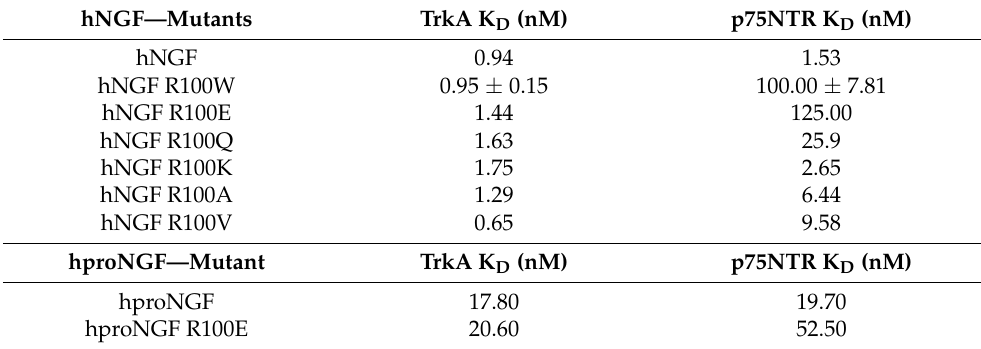
Table 3. Summary of the SPR derived equilibrium-binding constants K D (nM) of hNGF and hproNGF and of their mutants in position 100 towards TrkA and p75NTR receptors